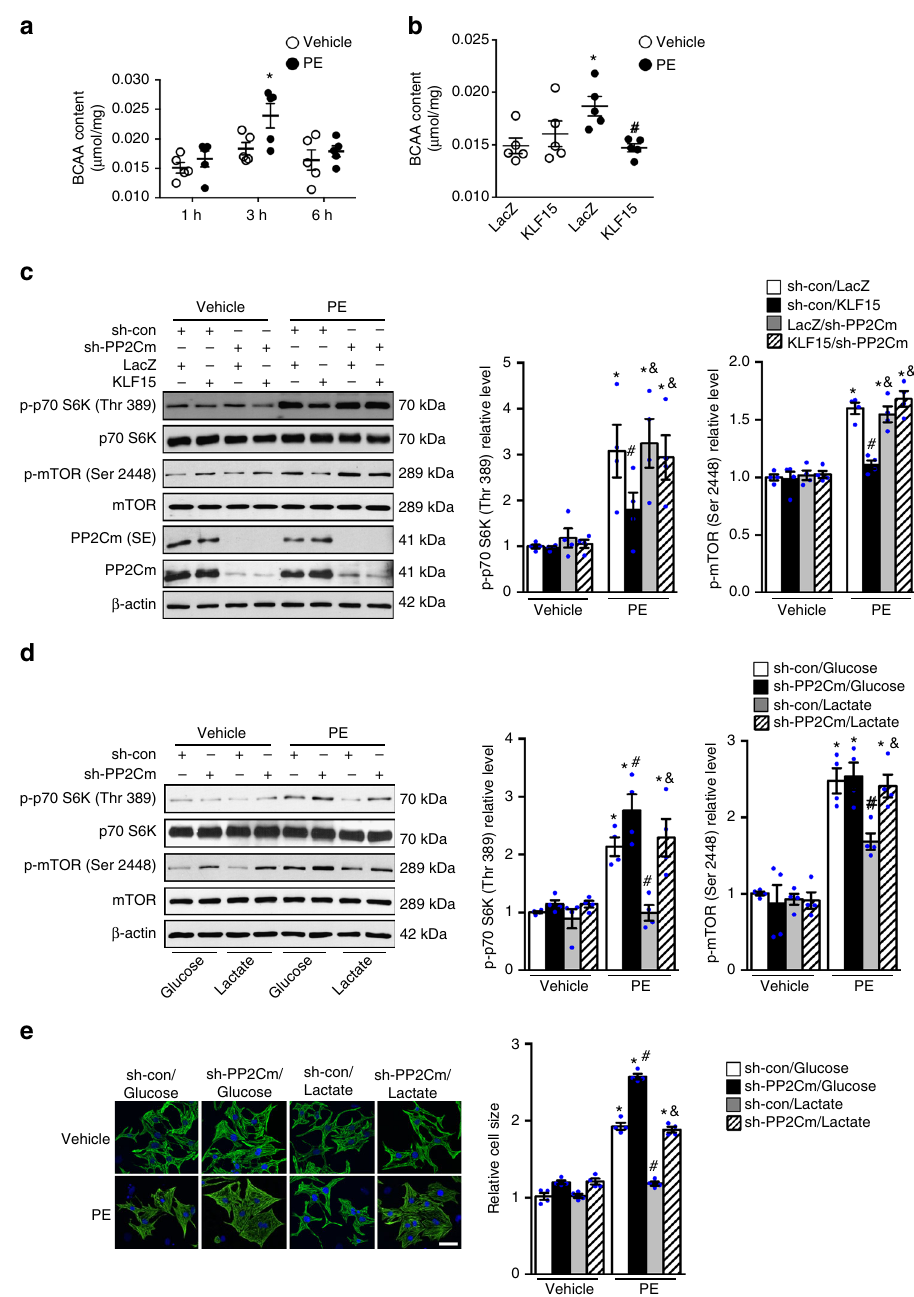
Fig. 6 BCAA accumulation is required for mTOR activation during cardiomyocyte growth. a Cellular BCAA level was measured in NRCMs treated with phenylephrine (PE, 100 μ M) or vehicle at indicated time points (* p < 0.05 vs. Vehicle, n = 5). b Cellular BCAA level was examined in NRCMs transduced with indicated adenovirus and treated with phenylephrine (PE, 100 μ M) or vehicle for 3 h (* p < 0.05 vs. LacZ/Vehicle, # p < 0.05 vs. LacZ/PE, n = 5). c NRCMs transduced with indicated adenovirus were treated with phenylephrine (PE, 100 μ M) or vehicle for 6 h. Immunoblots of cell lysates (left) and statistical analyses of densitomeric measurements of p-p70 S6K (Thr 389) and p-mTOR (Ser 2448) (right) are shown (* p < 0.05 vs. sh-con/LacZ/Vehicle, # p < 0.05 vs. sh-con/LacZ/PE, & p < 0.05 vs. sh-con/KLF15/PE, n = 4). SE for short exposure. d , e NRCMs transduced with indicated adenovirus were incubated with DMEM containing either glucose or non-glucose substrates for one hour and then treated with phenylephrine (PE, 100 μ M) or vehicle. d Immunoblots of cell lysates (left) and statistical analyses of densitomeric measurements of p-p70 S6K (Thr 389) and p-mTOR (Ser 2448) (right) are shown (* p < 0.05 vs. sh-con/Glucose/Vehicle, # p < 0.05 vs. sh-con/Glucose/PE, & p < 0.05 vs. sh-con/Lactate/PE, n = 4). e 48 h after PE treatment, myocytes were fi xed and stained with anti-Troponin T. Cell surface area in each group was quanti fi ed and expressed relative to the control (* p < 0.05 vs. sh-con/Glucose/Vehicle, # p < 0.05 vs. sh-con/Glucose/PE, & p < 0.05 vs. sh-con/Lactate/PE, n = 4). Scale bar, 25 μ m. Data shown as mean ± s.e.m. P values were determined using one-way ANOVA followed by Newman-Keuls comparison test ( a , b , c , d ) or Kruskal – Wallis test followed by Dunn ’ s comparison test ( e